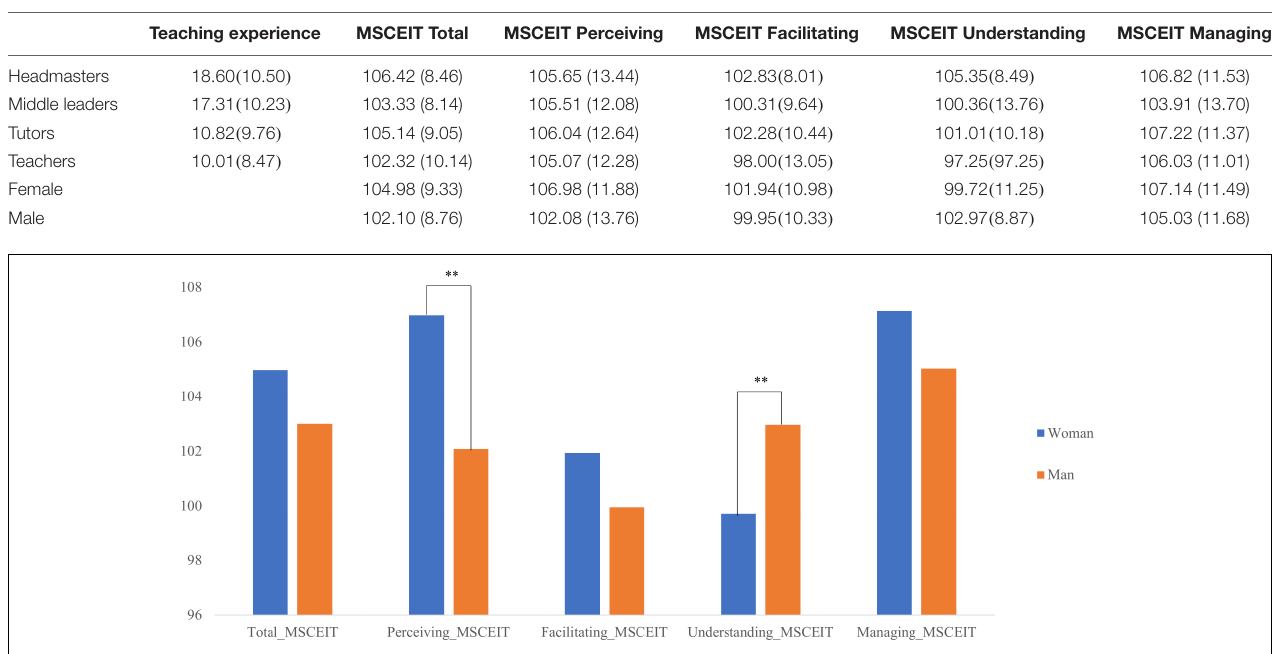
TABLE 1 | Mean and standard deviation of the study variables.